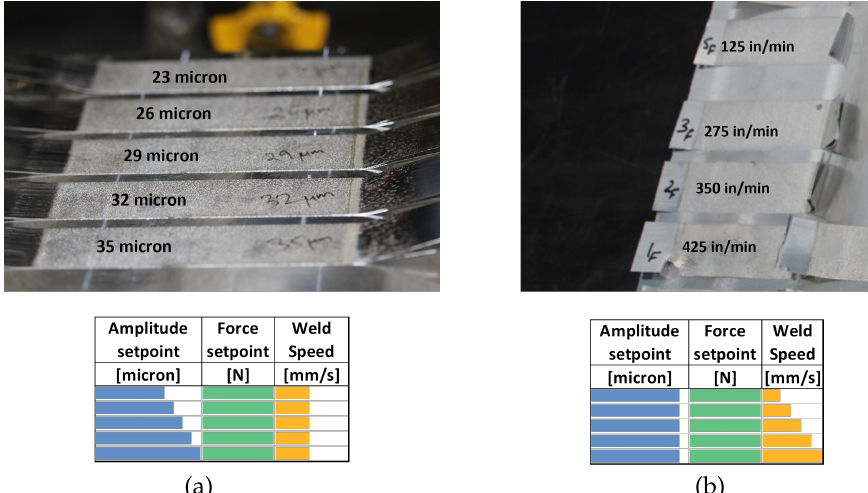
Figure 10. Study to determine the effect of UAM process settings on the weld interface microstructure at a fixed weld force of 5000 N: ( a ) weld amplitude varied with a fixed weld speed of 84.67 mm/s (200 in/min); ( b ) weld speed varied with a fixed weld amplitude of 29 µ